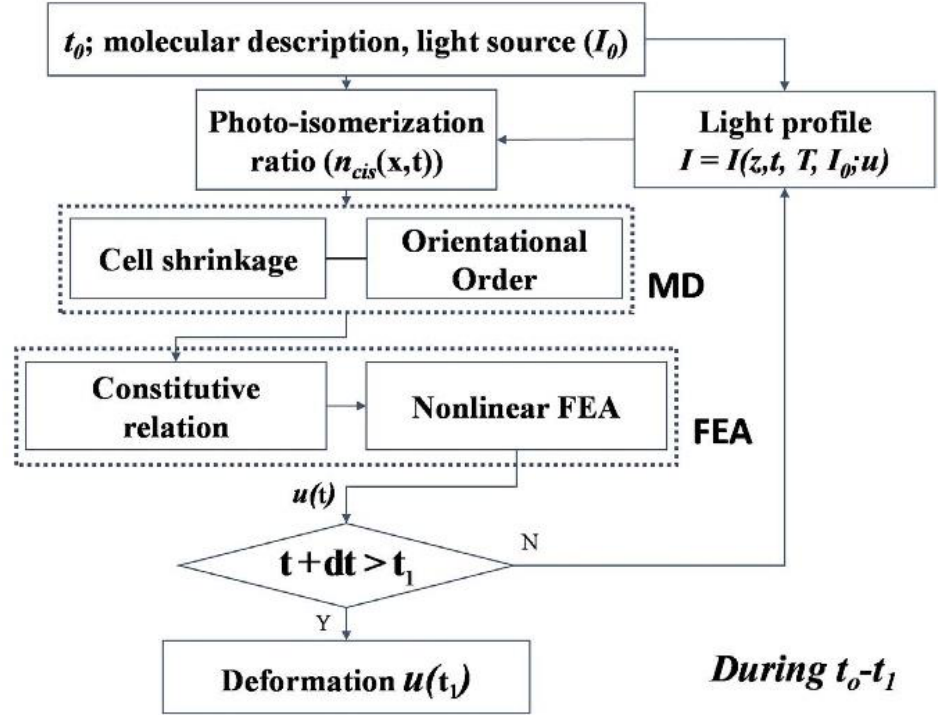
Figure 12. Workflow of the multiscale model. At an instance in time (t), a photoisomerization ratio is calculated for given values of light intensity (I o ) and temperature (T); and then is used for carrying out MD simulations, which in turn will provide microscopic information to the nonlinear FEA [103] (Reprinted with permission from [103]).